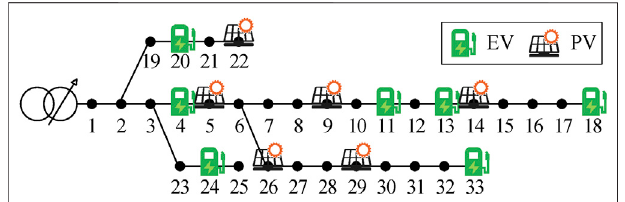
FIGURE 8 | The test feeder